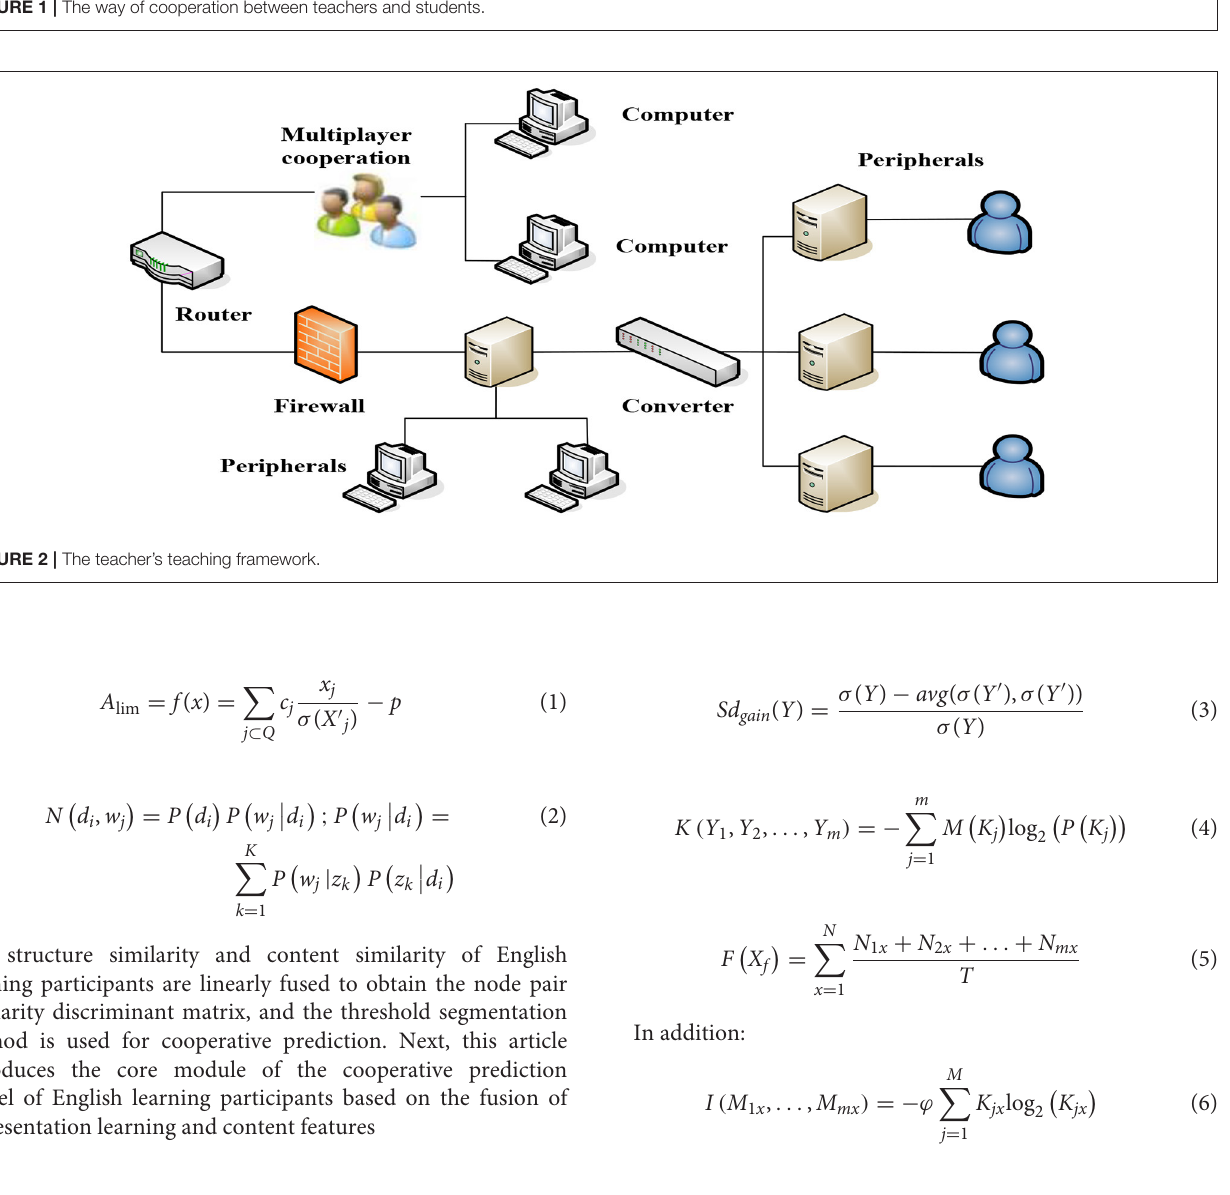
FIGURE 1 | The way of cooperation between teachers and students.